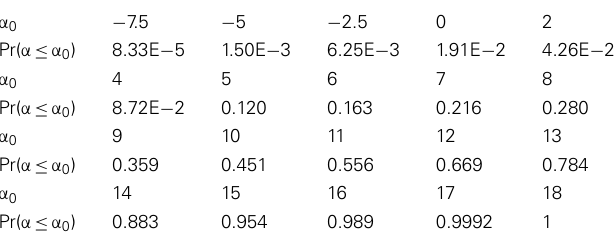
Table 6 | α -Value cdf for cancer cells in a clinically detectable tumor.